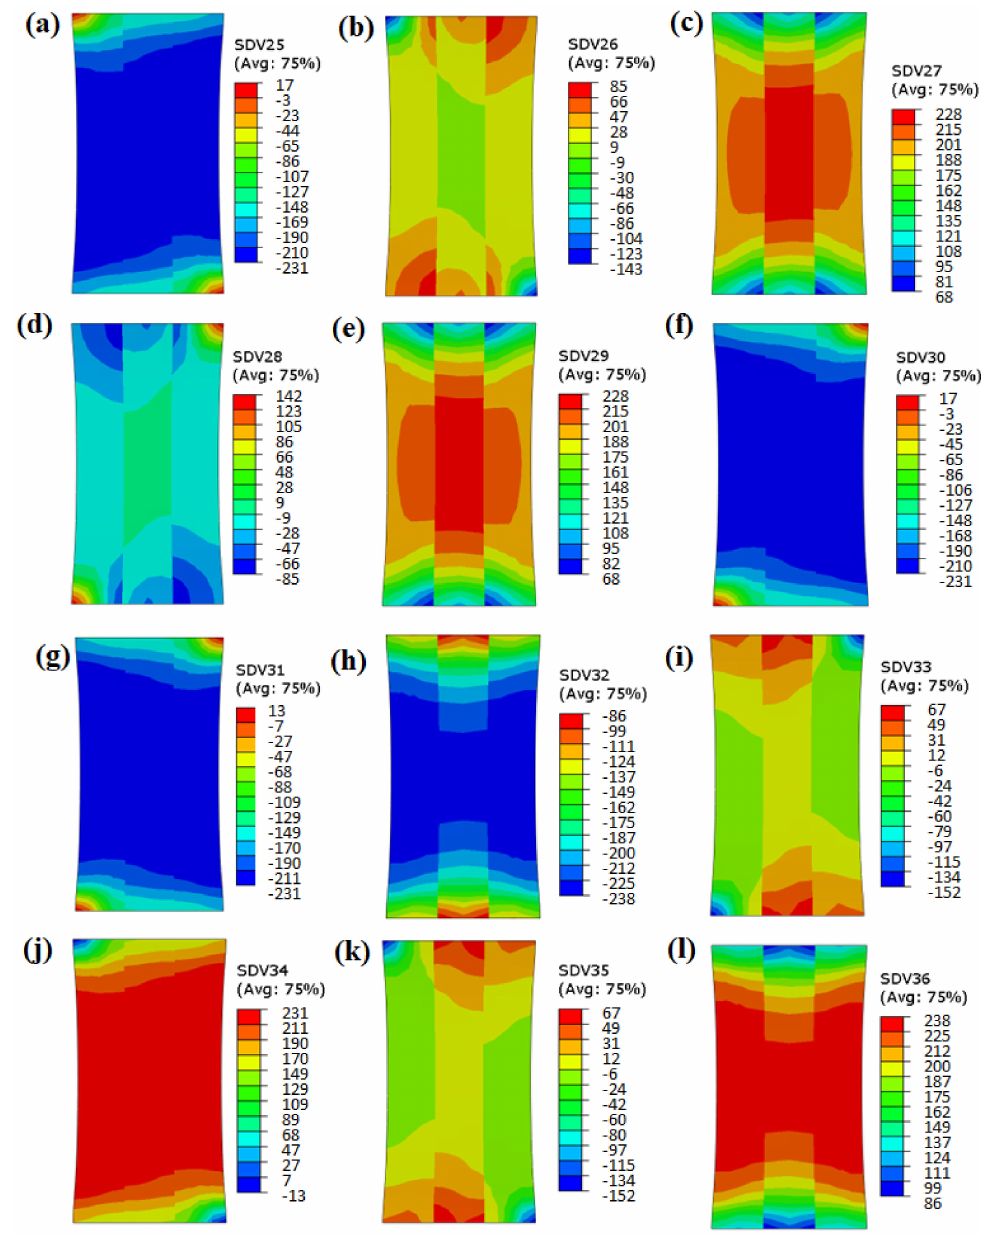
Figure 13. Shear stress of slip systems 1–12 with misorientation angle of 5 ◦ (SDV 25–SDV